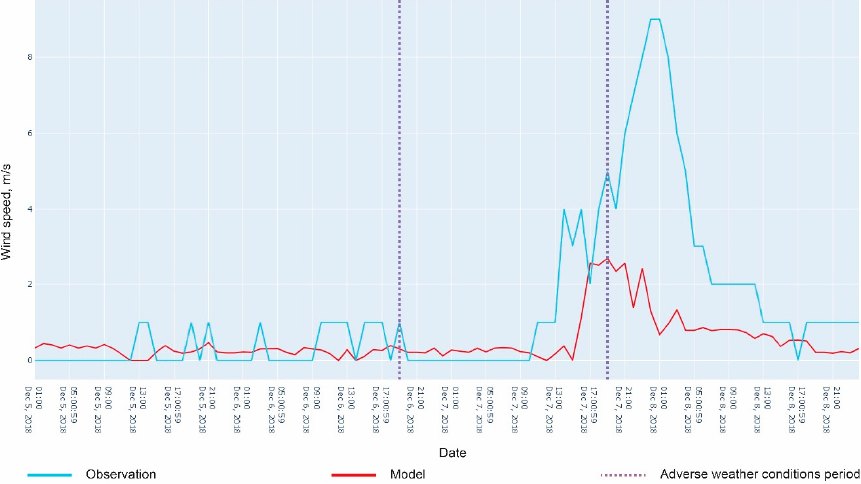
Figure 10. Simulated and observed wind speeds (meteorological station code 29570).